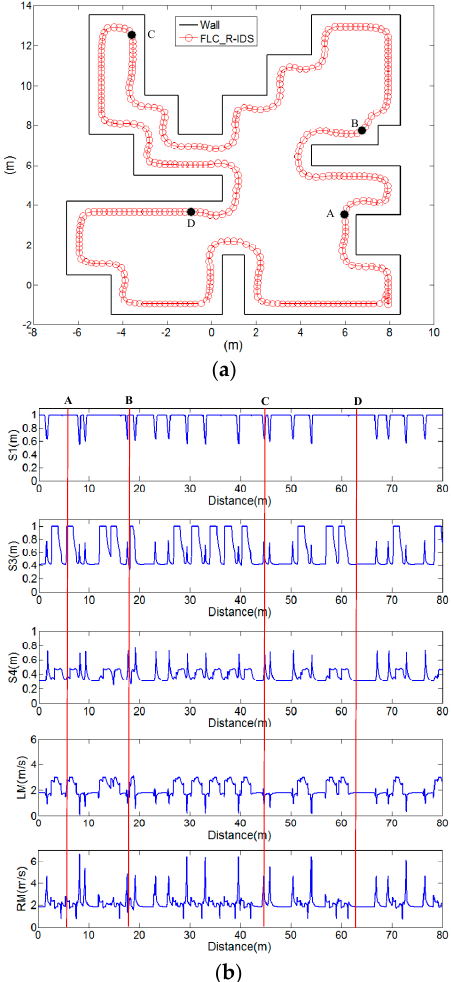
Figure 11. ( a ) Mobile robot path tracking, ( b ) ultrasonic sensors values, and the left-wheel and right-wheel speeds of the robot in the test environment 2 for the FLC_R-IDS method.